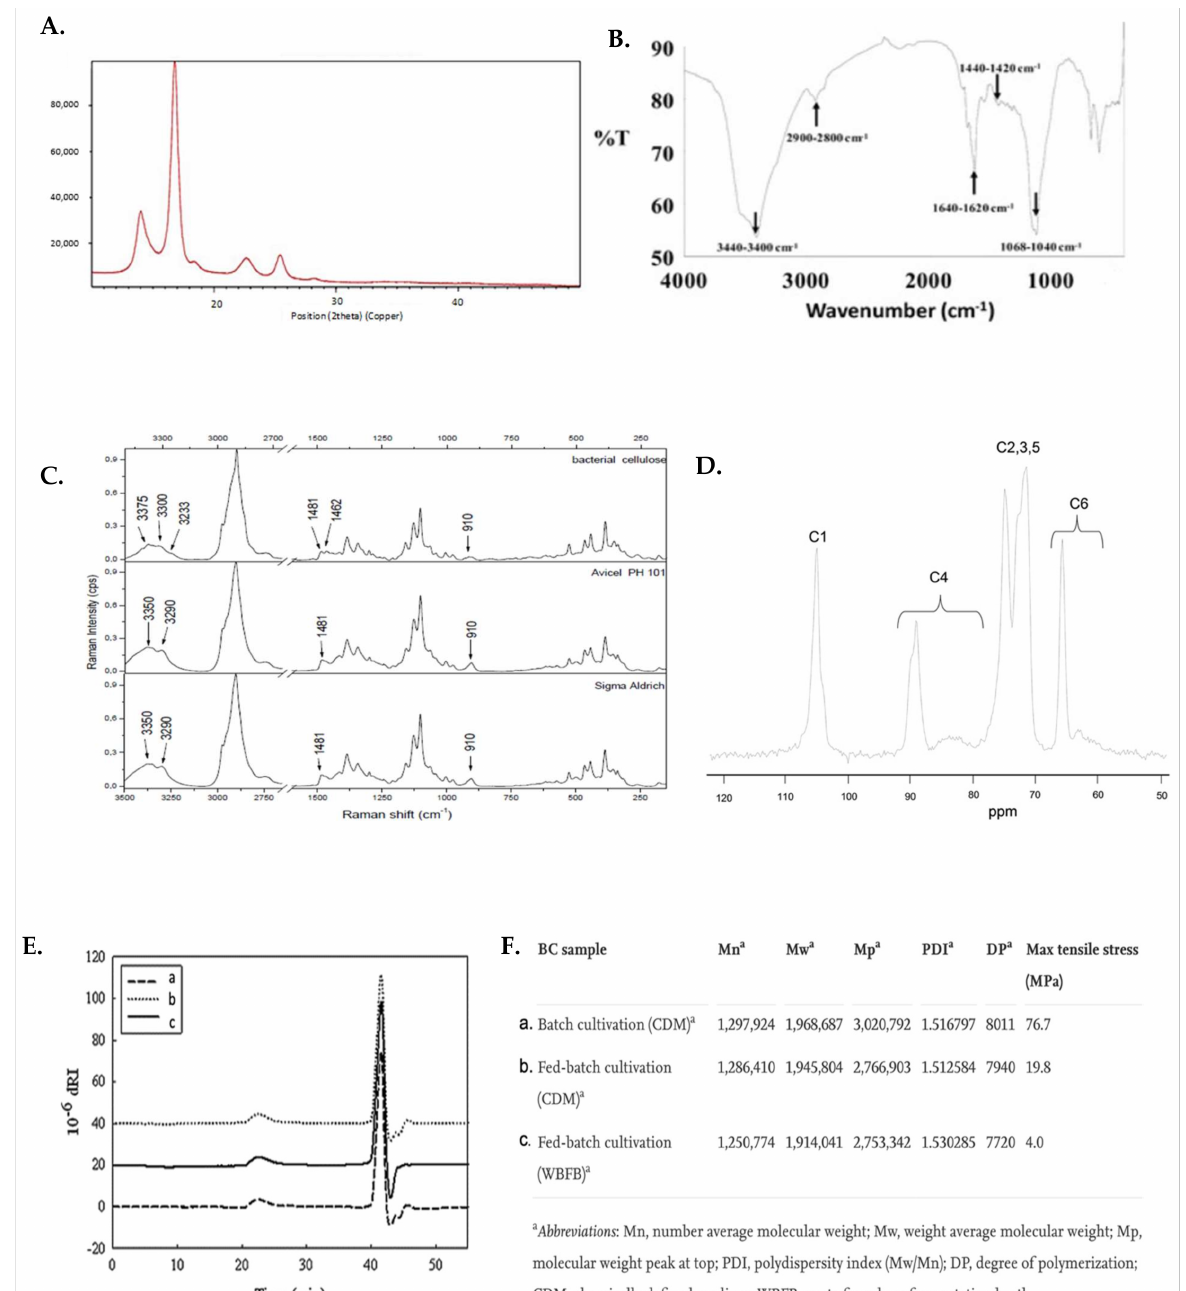
Figure 2. ( A ) X-ray diffraction spectrum ( B ) FTIR spectrum ( C ) Raman Spectra comparing BC, Sigma Aldrich and Avicel PH10 samples [29]. ( D ) CPMAS 13 C-NMR spectrum of BC fully 13 C labeled obtained without treatment and its carbon signal assignment. ( E ) GPC analysis of BC samples produced via batch cultivation in chemically defined medium (a), fed-batch cultivation of chemically defined medium (b), and fed-batch cultivation of waste from beer fermentation broth (WBFB) (c) in static conditions in a Jar fermenter, ( F ) table showing the molecular weight distribution obtained from GPS. Reproduced with permission from [38] (Copyright © 2022, Springer Science Business Media B.V., part of Springer), [39] (Copyright © 2022, Elsevier), [36] (Copyright © 2022